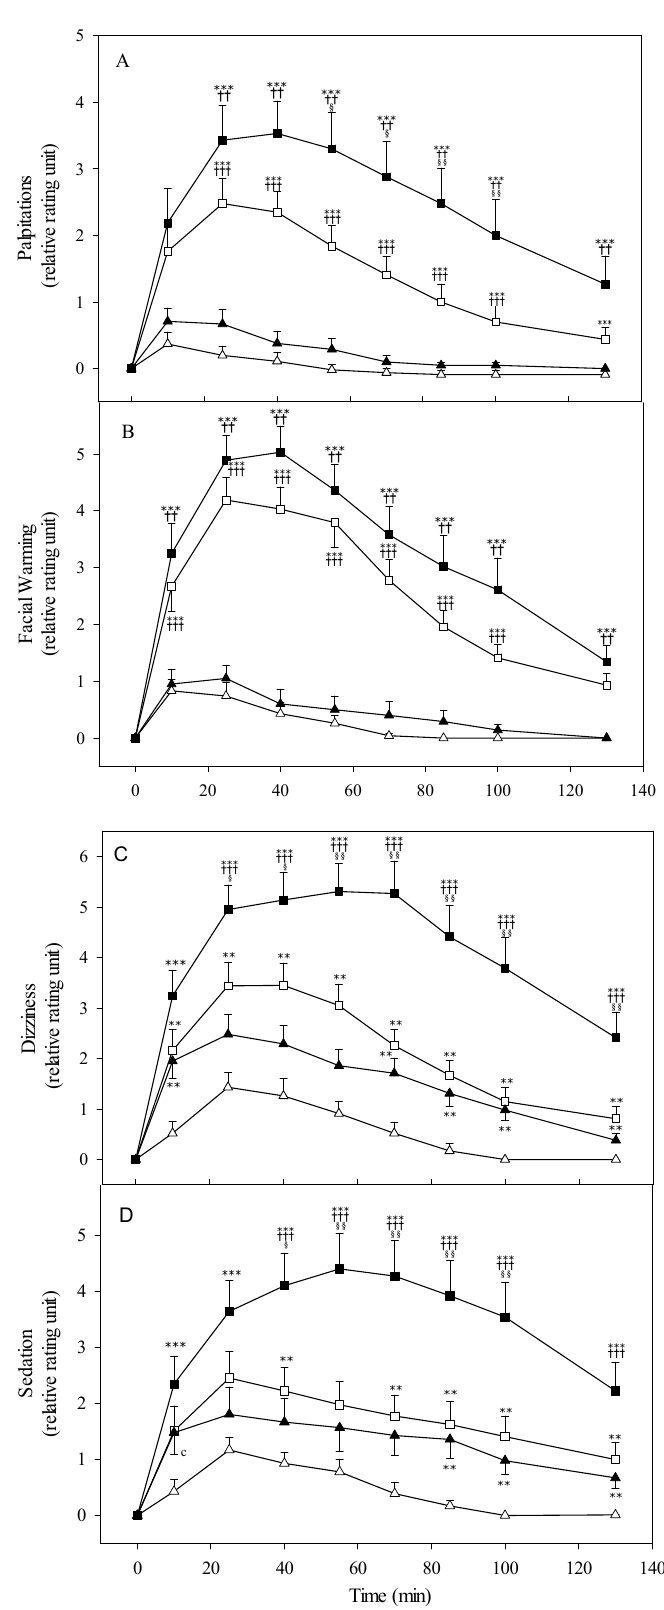
Figure 4. Alterations in subjective perceptions of palpitations ( A ), facial warming ( B ), dizziness ( C ), and sedation ( D ) of nonalcoholic subjects with different ALDH2 allelotypes following different doses of ethanol (0.3 g/kg body weight or 0.5 g/kg). All subjects are ADH1B*2/*2 homozygote. The study groups are denoted as △ , ALDH2*1/*1 with 0.3 g/kg ethanol ( n = 23); ▲ , ALDH2*1/*1 with 0.5 g/kg ethanol ( n = 21); □ , ALDH2*1/*2 with 0.3 g/kg ethanol ( n = 27); ■ , ALDH2*1/*2 with 0.5 g/kg